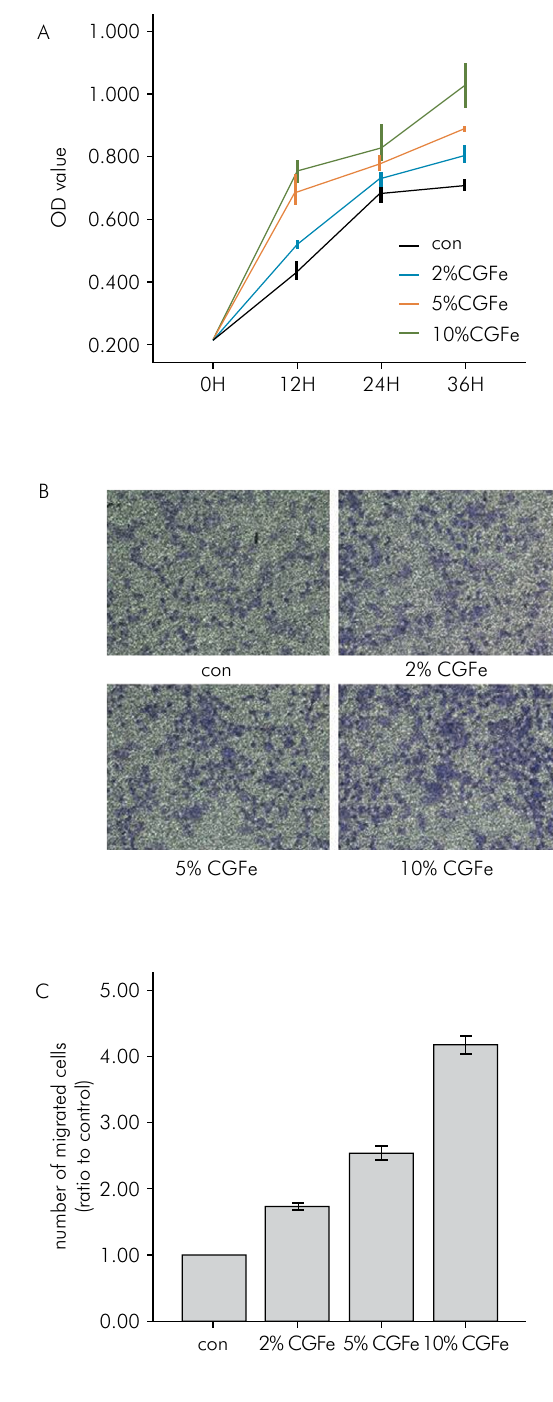
Figure 2. Effects of CGFe on the cell proliferation and migration of HUVECs. (A) CGFe significantly accelerated HUVEC proliferation in a dose-dependent manner at concentrations ≤ 10% (p < 0.05). (B) Representative images for each group are shown above. (C) Quantification of migrated cells. As suggested, CGFe also promoted HUVEC migration in a dose-dependent manner (p < 0.05). All data are presented as the mean ± SE of three independent